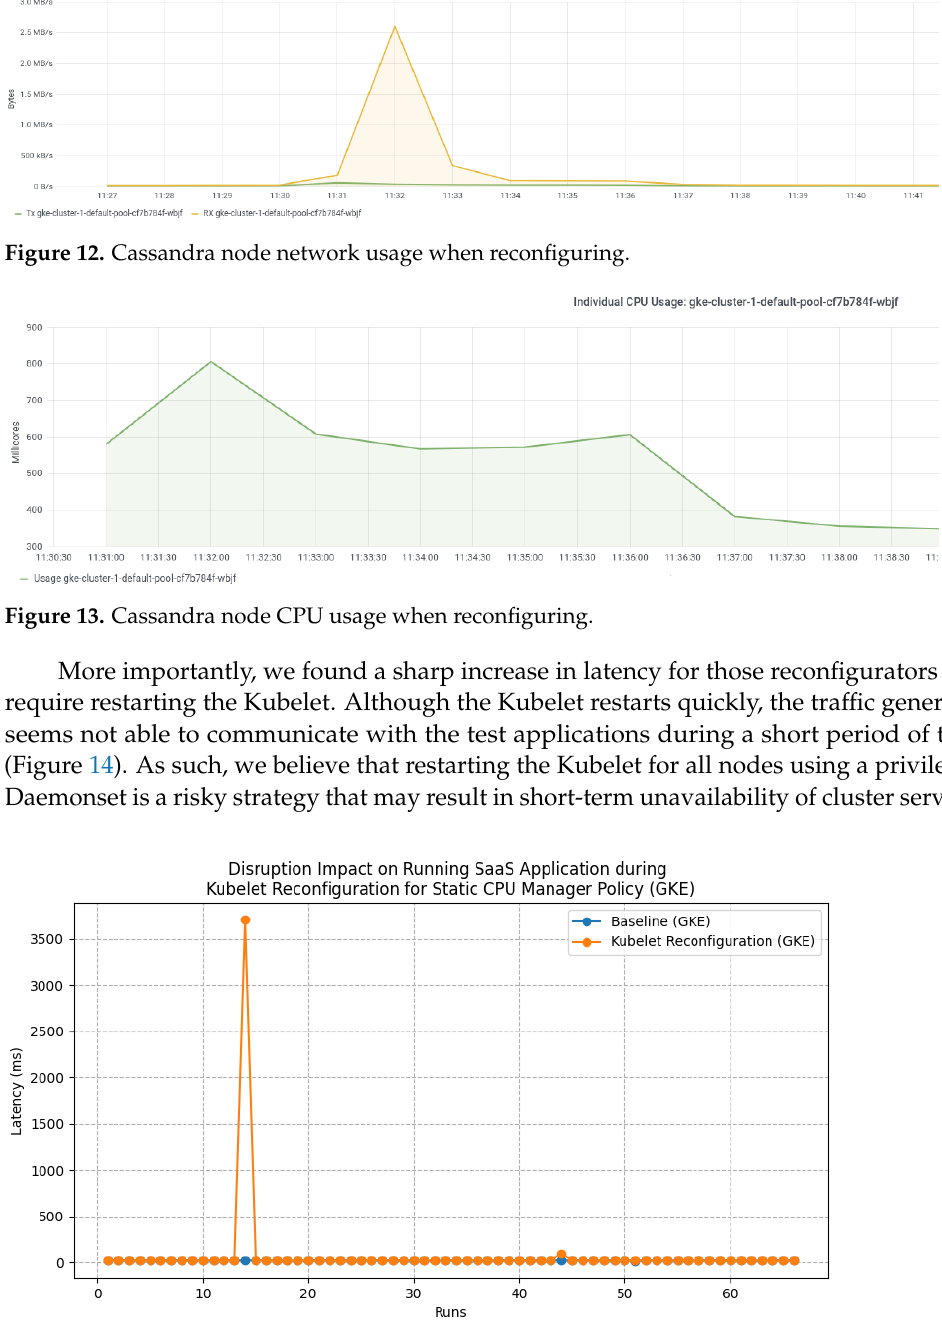
Figure 14. Disruption Impact on SaaS application (During Kubelet restart, no traffic routed to the